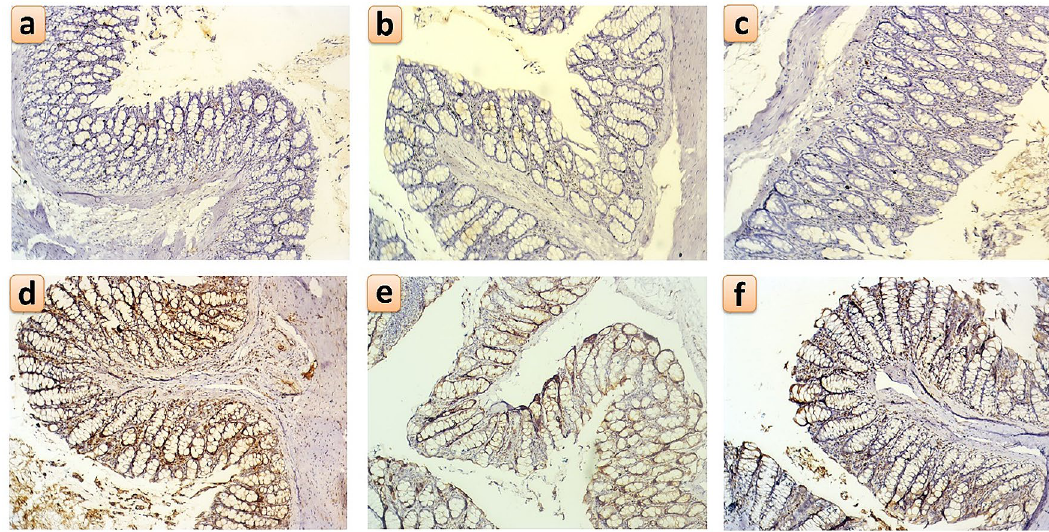
Figure 9. Immunohistochemical staining for IL-6 positive cells within the colonic mucosa and submucosa following oral administration of B. amyloliquefaciens (BA) or BA-nanoparticles (BANPs) in non-colitic and colitic rats. Non-colitic groups including Control ( a ), BA ( b ) and BANPs ( c ) groups. While, colitic groups include DSS ( d ), DSS + BA ( e ) and DSS + BANPs ( f ) groups .